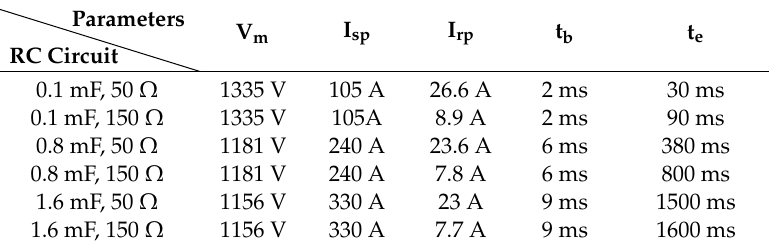
Table 5. E ff ects of di ff erent RC circuits on blocking